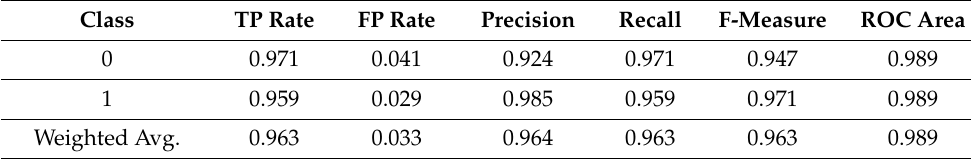
Table 10. Evaluation metrics for J48 DT.